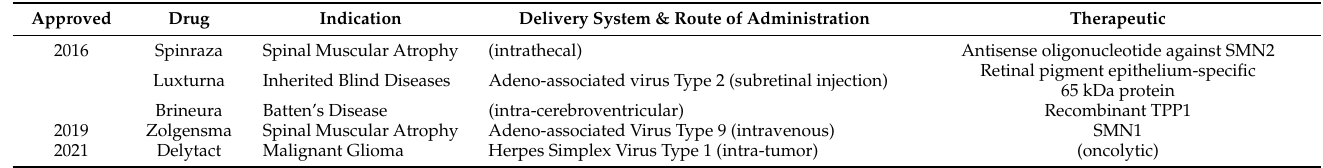
Table 1. Approved gene therapy-based drugs for the treatment of CNS